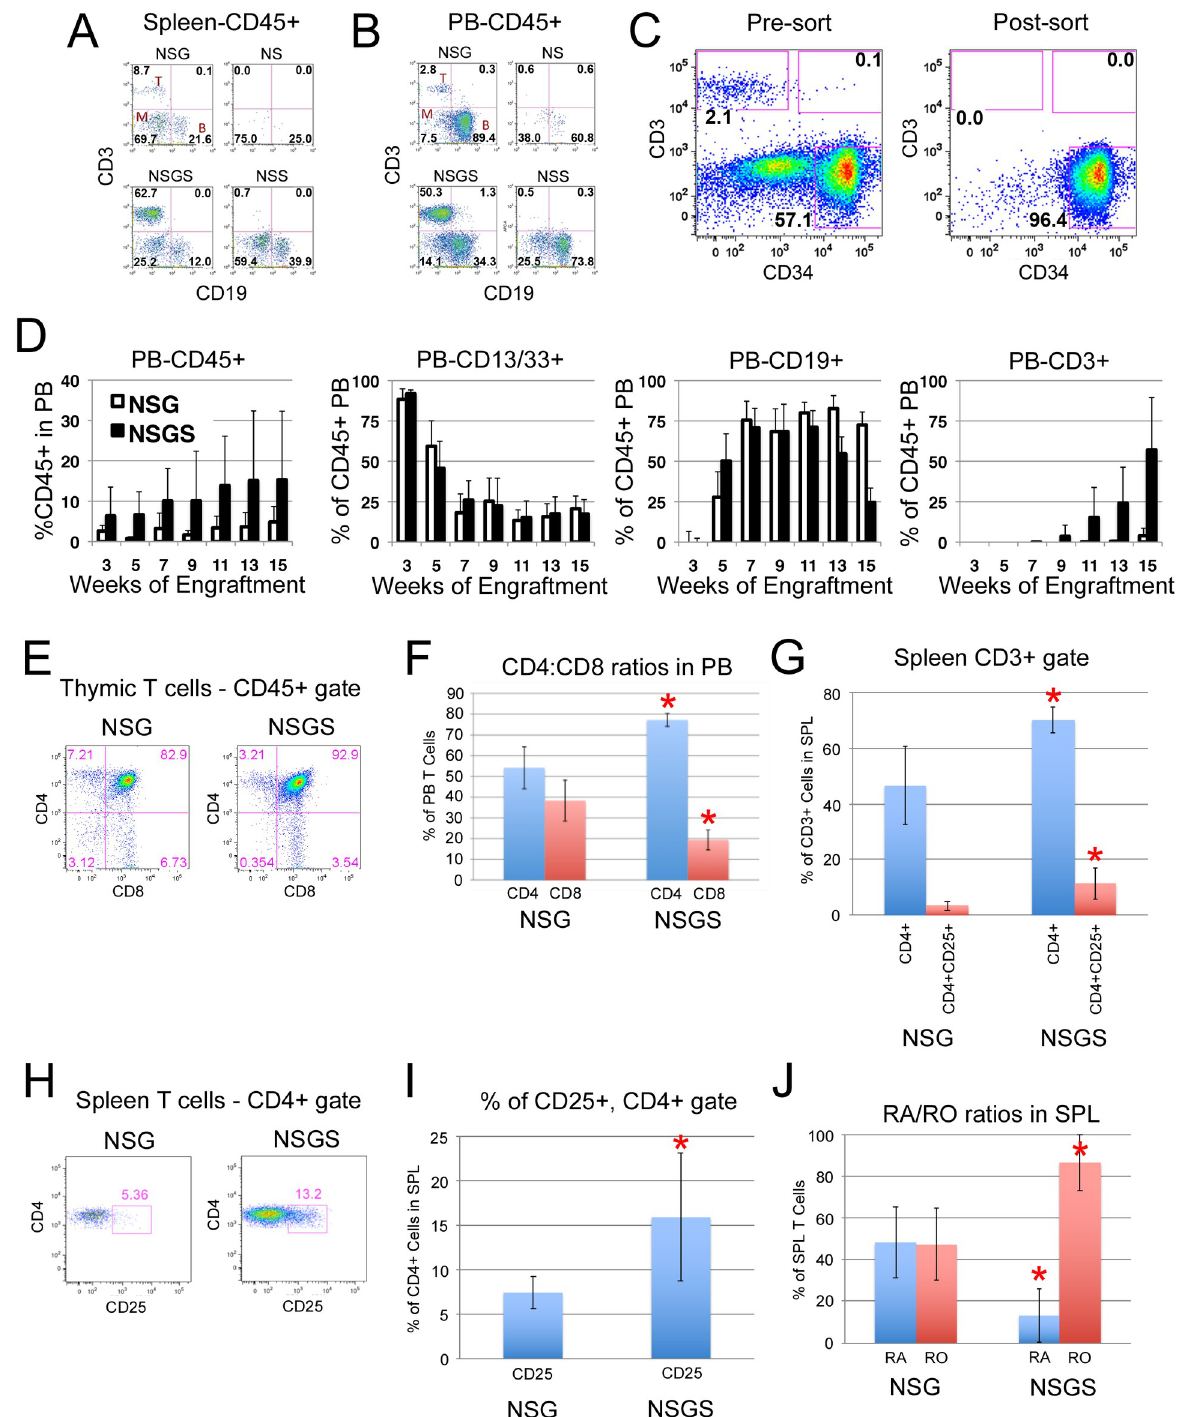
Fig 6. Rapid T cell differentiation in NSGS mice. Representative flow plots from week 16 engrafted mice showing lineage distribution in A) spleen and B) PB. C) Flow plots showing potential T cell contamination in CD34+ isolations that was removed by FACS sorting CD34+CD3- cells. D) Kinetics of total human, B, myeloid, and T cells engraftment in the PB of NSG and NSGS mice engrafted with the same FACS sorted UCB CD34+CD3- samples. E) Thymus FACS analysis shows normal double positive primitive T cells. F) PB CD4 and CD8 frequencies among CD3+ T cells. G) Spleen Tregs were enumerated. A representative flow plot example is shown in H and the data is displayed as percentage of CD4 cells in I. J) RA/RO ratios in spleen CD3+ cells. Panels E-J were completed 15 weeks after engraftment. Asterisks indicate p value less than 0.05 by Student’s T